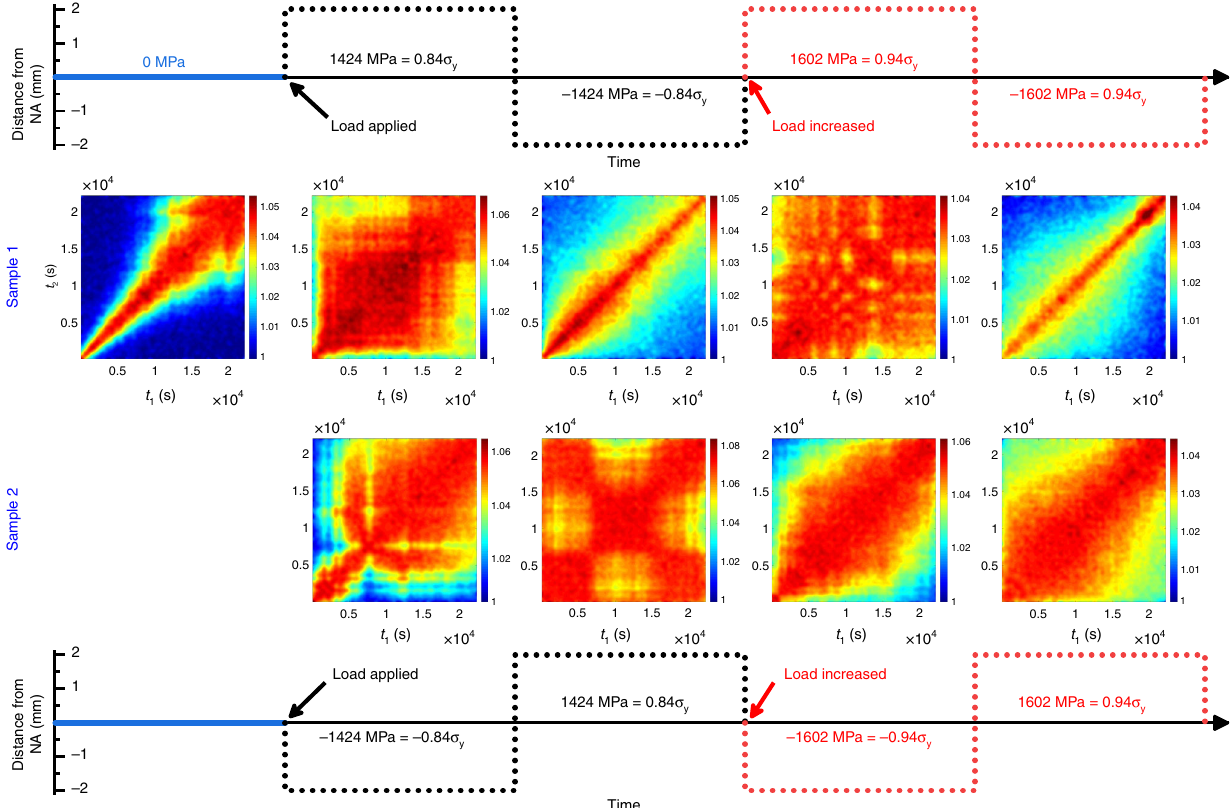
Fig. 3 In situ bending with compressive and tensile stresses. Two-time correlation functions for two MG bars (Sample 1 and Sample 2), measured under different compressive and tensile stresses of different magnitude. The zero-load TTCF is also shown for Sample